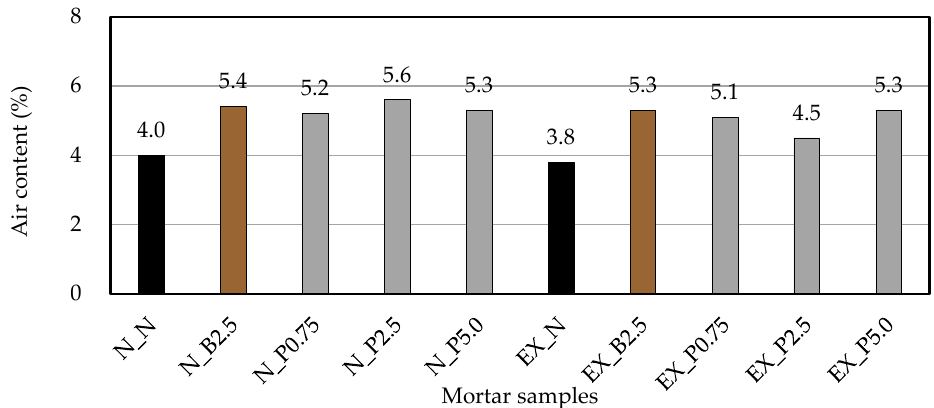
Figure 4. Air content in the fresh mortar. (black: without NFBC, brown: with NFBC type B f , grey: with NFBC type P f )